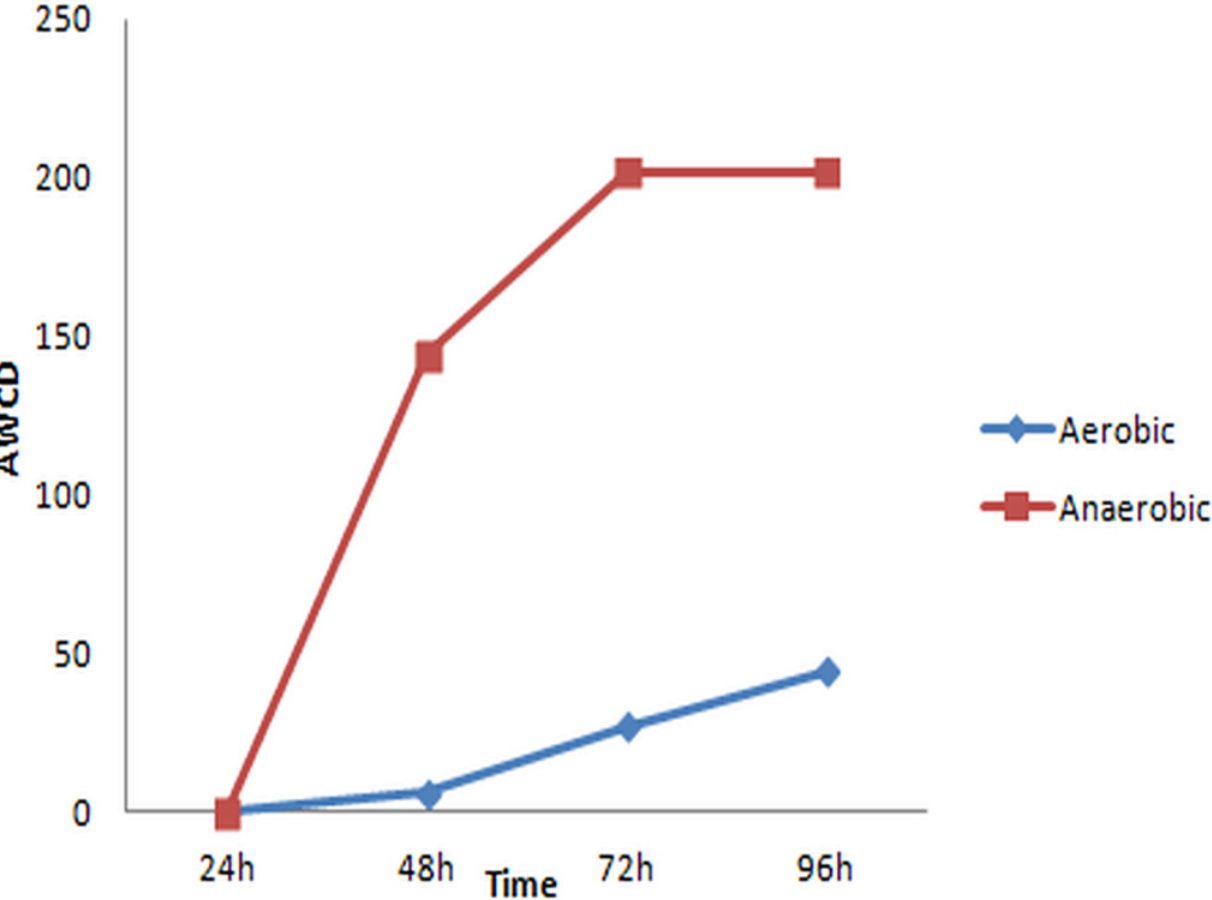
Fig 6. Average well-color development (AWCD) calculated from the consumption of carbon sources of anaerobic and aerobic microbial communities.